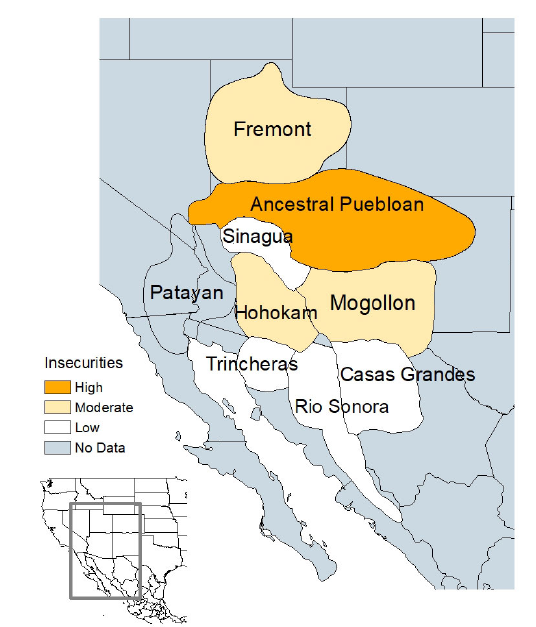
Fig. 3 . Food insecurity prior to depopulation (indicator: increasing resource depletion/